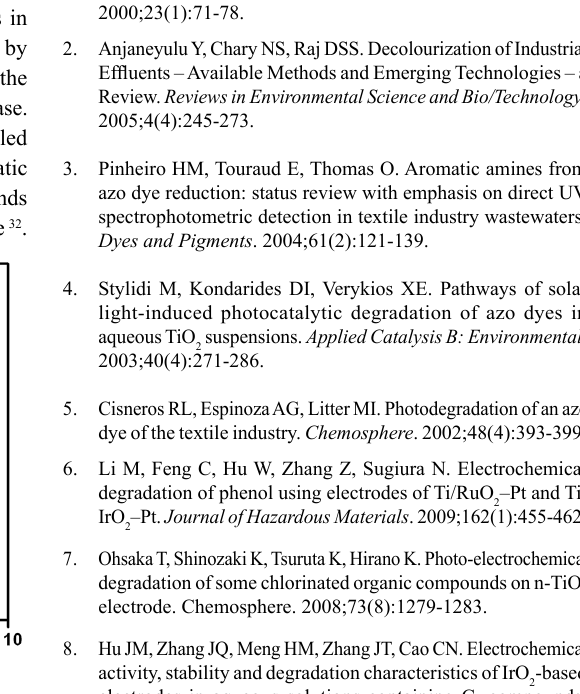
Figure 11. Normalized total chromatographic area as a function of applied current density in each